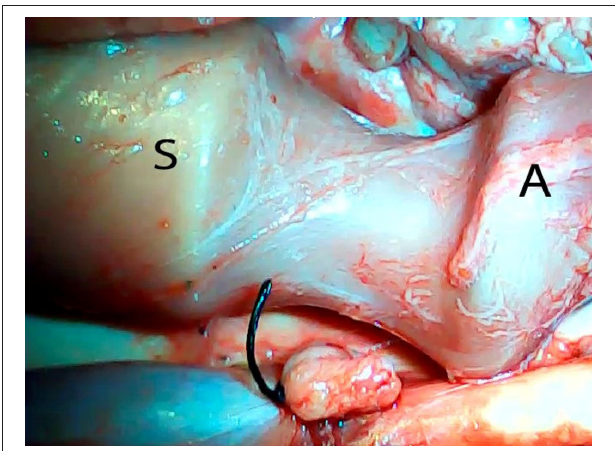
FIGURE 2 | Opening of the circular stapler within the mobilized portion of the esophagus. S, stapler; A, anvil.